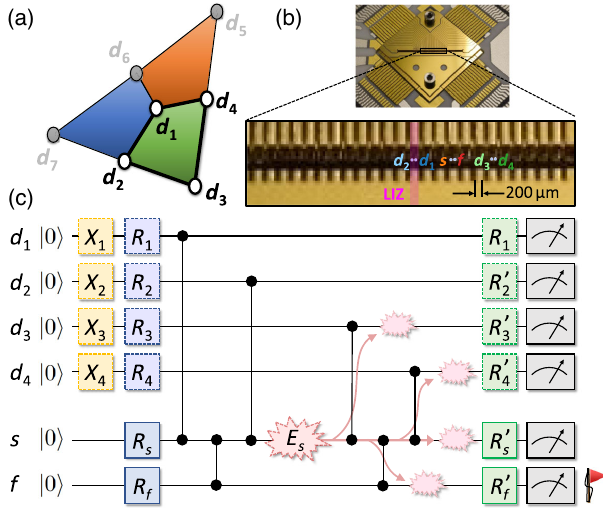
FIG. 1. (a) Sketch of the ½½ 7 ; 1 ; 3 (cid:2)(cid:2) color code highlighting a plaquette comprised of data qubits d 1 – d 4 . (b) Segmented microchip ion trap showing how the qubits are distributed at the beginning of the PCM sequence. (c) Quantum circuit realizing the FT PCM on four data qubits. Two additional gates couple the syndrome to the flag qubit, allowing for detecting potentially uncorrectable faults.